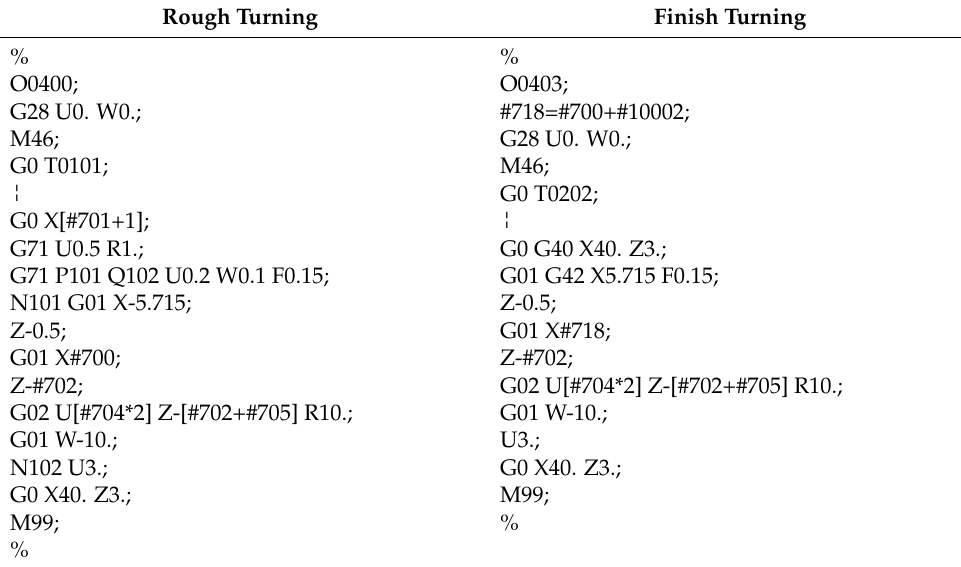
Table 2. Macro programming for cylinder rough turning and finish turning.